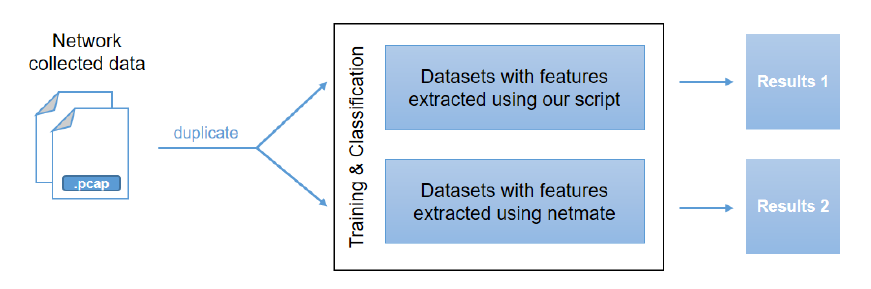
Figure 6. Second iteration of the classification